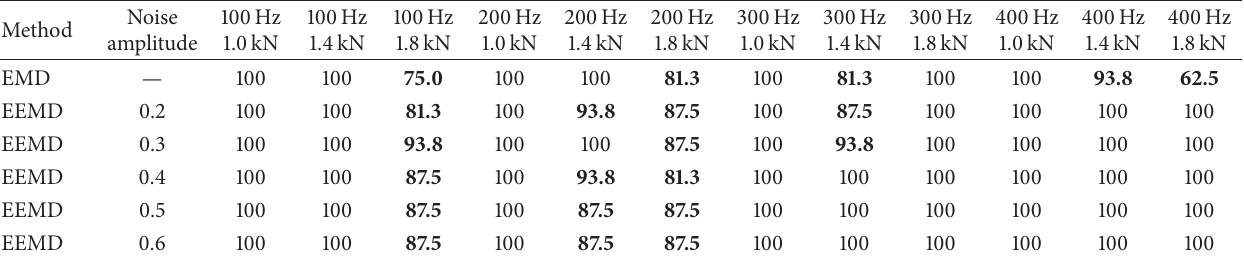
Table 1: The classification rates for different operating conditions (signals collected in 𝑌 direction).